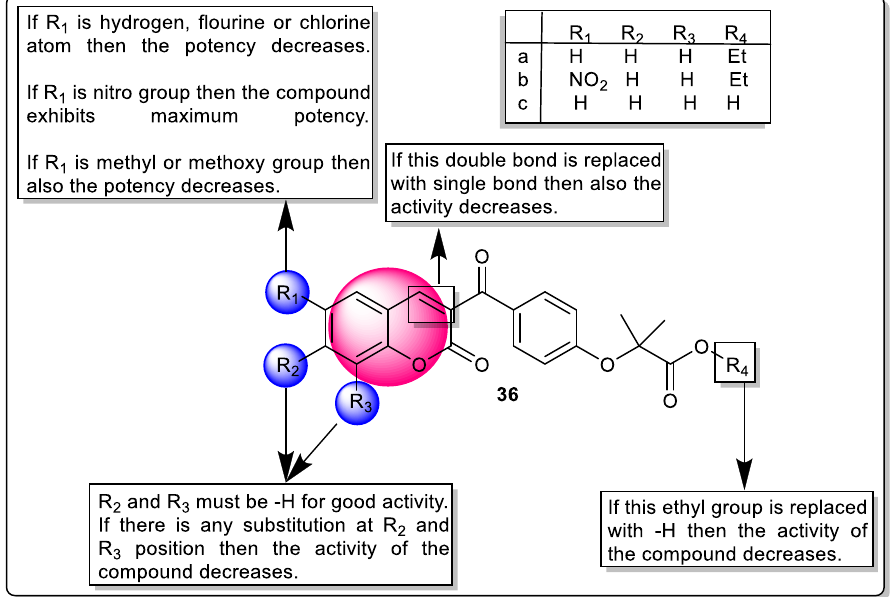
Figure 40. Structural activity relationship of coumarin – chalcone hybrids ( 36 ) as potent PPAR lig-